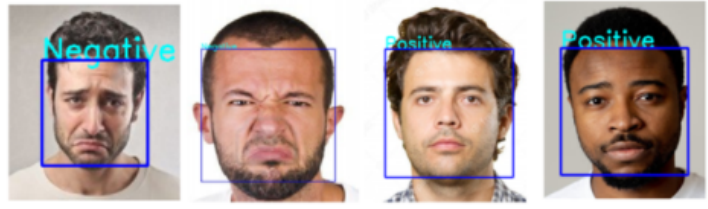
Figure 22. Accurately Classified Images 2 × Negative and Positive.